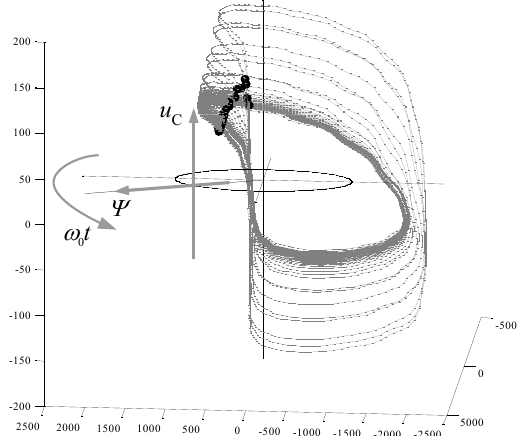
Fig. 3. Three dimensional representation of trajectory generated through the rotating  – u C plane for an examined ferroresonance transient state.